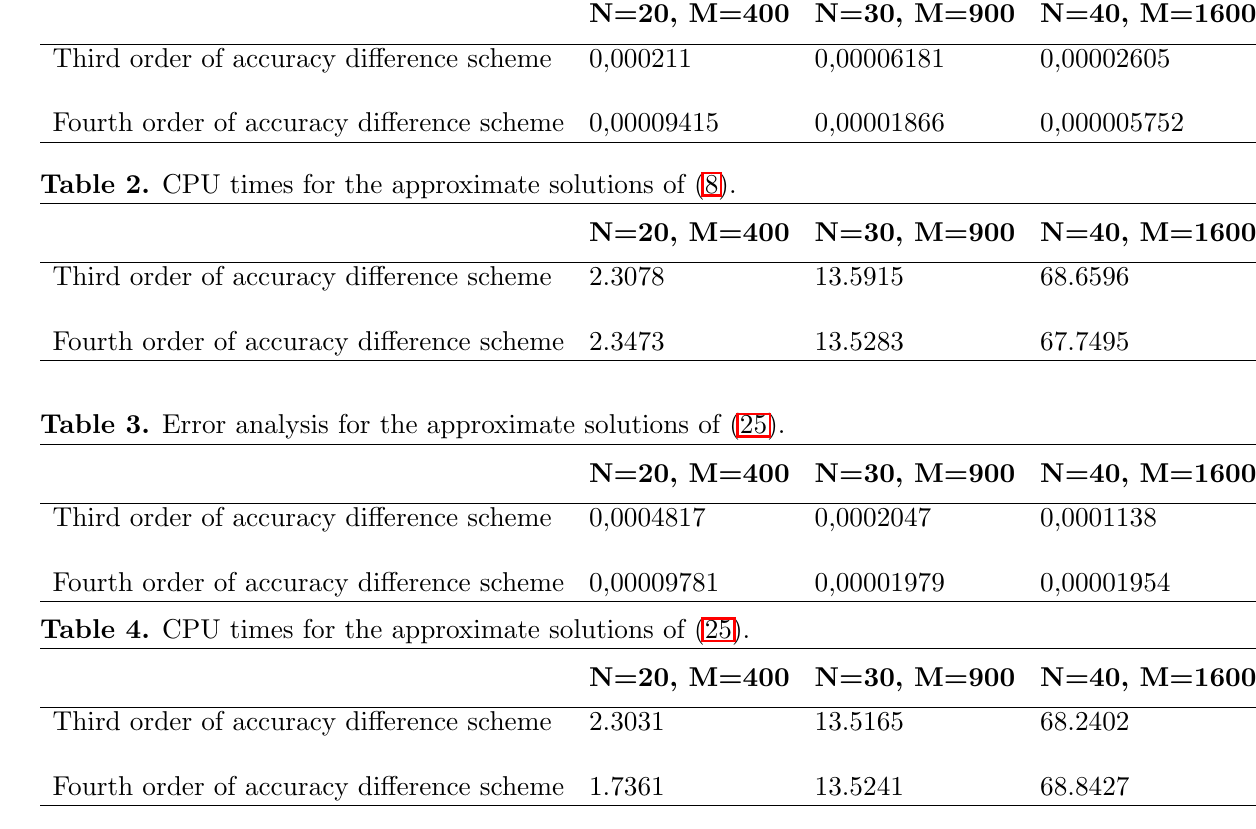
Table 1. Error analysis for the approximate solutions of (8).